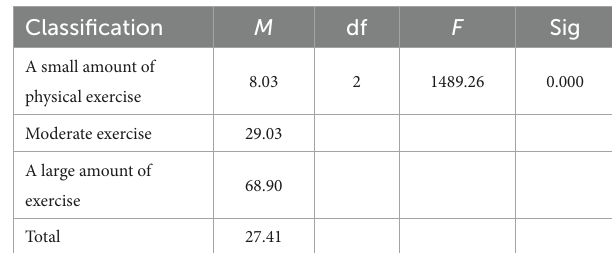
TABLE 1 Division of physical exercise of college